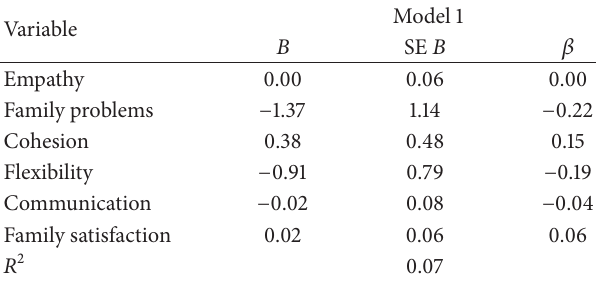
Table 5: Hierarchical multiple regression associations between caregiver income, family dynamics factors, and